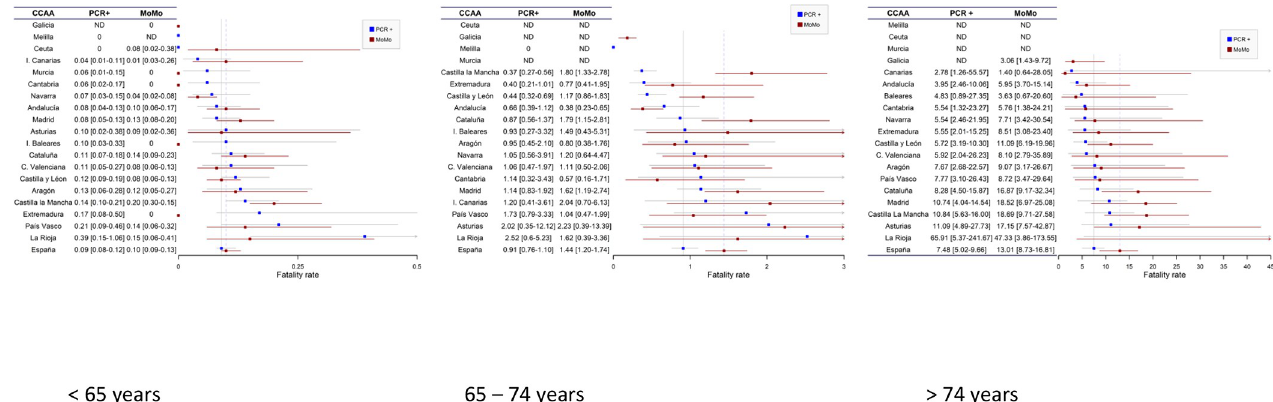
Fig 2. Case fatality rates with ranges according to prevalence of infection and age groups calculated by official number of deaths (PCR+) and by excess mortality (MoMo) in the different Autonomous Communities (CC.AA).